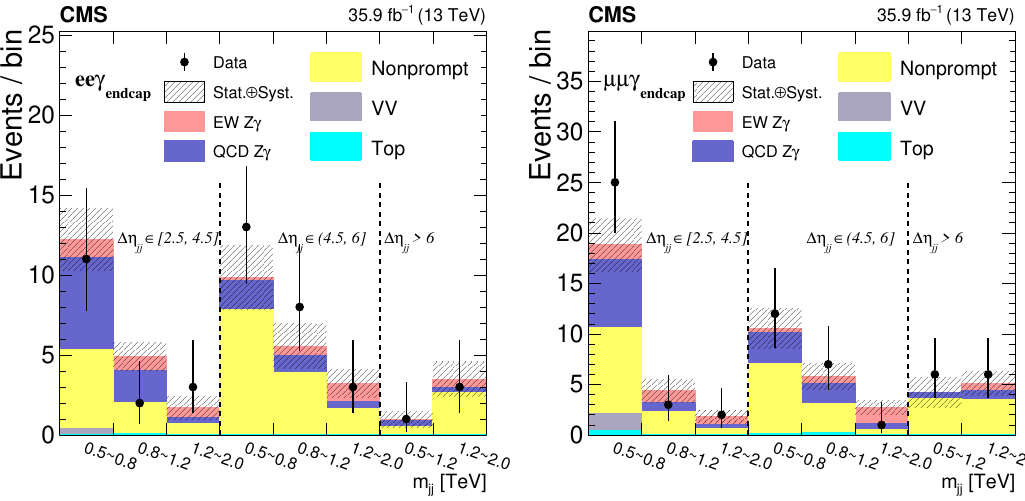
Figure 5 . The post-(cid:12)t 2D distributions of the dielectron (left) and dimuon (right) + (cid:13) categories as a function of m in bins of (cid:1) (cid:17) . The horizontal axis is split into bins of (cid:1) (cid:17) jj jj 4.5], (4.5, 6.0], and > 6 : 0. The data are compared to the signal and background predictions in the signal region. The black points with error bars represent the data and statistical uncertainties of data, the hatched bands represent the full uncertainties of the predictions.